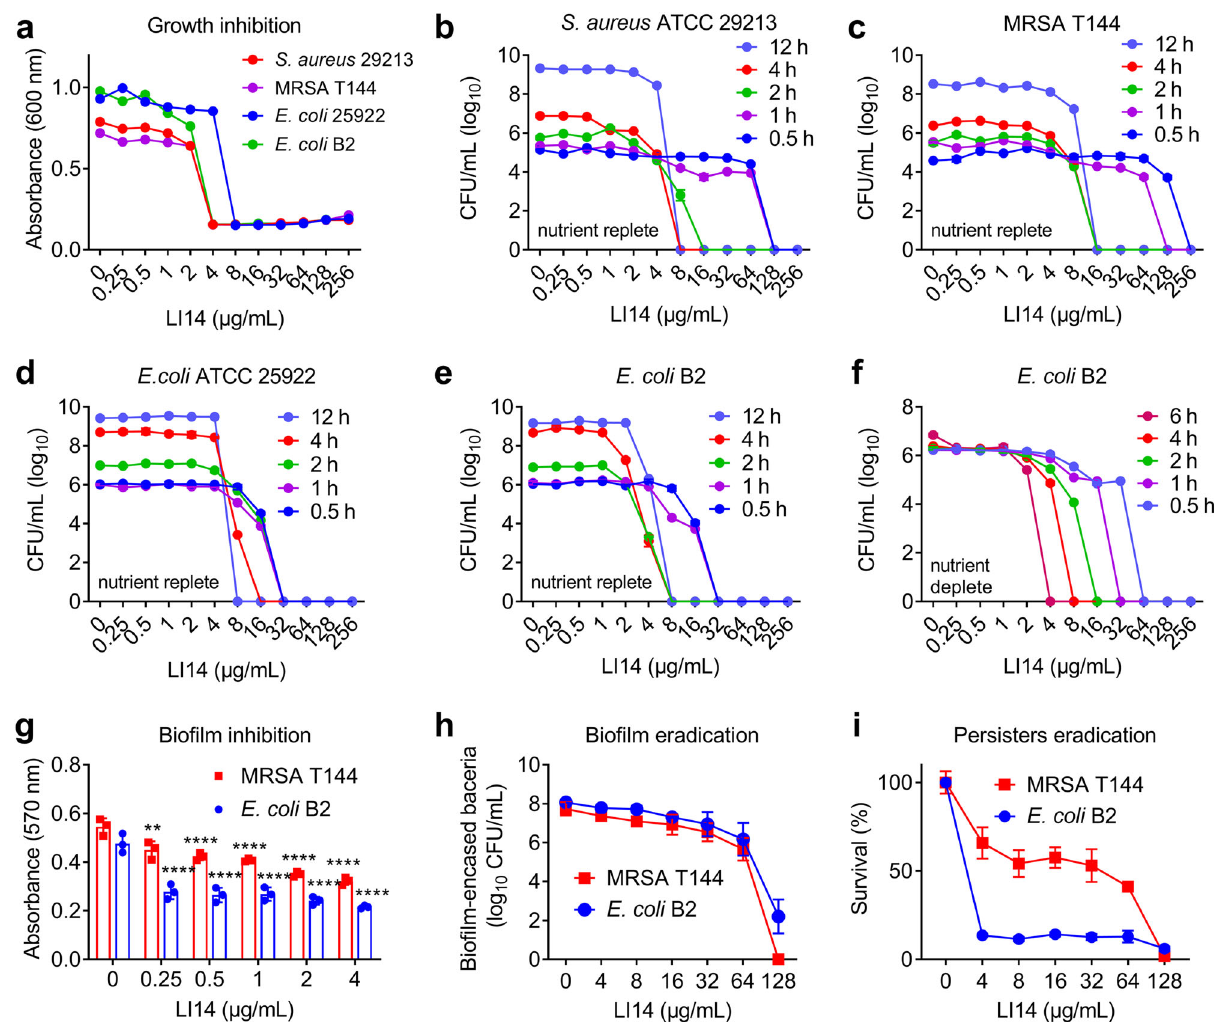
Fig. 2 LI14 peptide is a potent broad-spectrum bactericidal agent. a Growth inhibition of four strains involves S. aureus ATCC 29213, MRSA T144, E. coli ATCC 25922, and E. coli B2 after incubation with various concentrations of LI14 peptide for 18 h at 37 °C. b – e Killing of S. aureus ATCC 29213 ( b ), MRSA T144 ( c ), E. coli ATCC 25922 ( d ), and E. coli B2 ( e ) in MHB broth in the presence of difference concentrations of LI14 peptide after incubation for 0.5 to 12 h at 37 °C. The initial cell density of ~10 5 CFUs/mL for Gram-positive bacteria, ~10 6 CFUs/mL for Gram-negative bacteria. f Killing of E. coli B2 in PBS (nutrient depletion) treated by the varying concentrations of LI14 after incubation for 0.5 – 6 h at 37 °C. g Bio fi lm inhibition ability of sub-inhibitory concentrations of LI14 peptide against two tested strains, MRSA T144 and E. coli B2. One-way ANONA was used to determine the statistical signi fi cance (** P < 0.01 and **** P < 0.0001). h , i LI14 ef fi ciently eradicates established bio fi lms ( h ) and persister cells ( i ) of MRSA T144 and E. coli B2. Experiments were conducted with three biological replicates and data were shown as mean ±